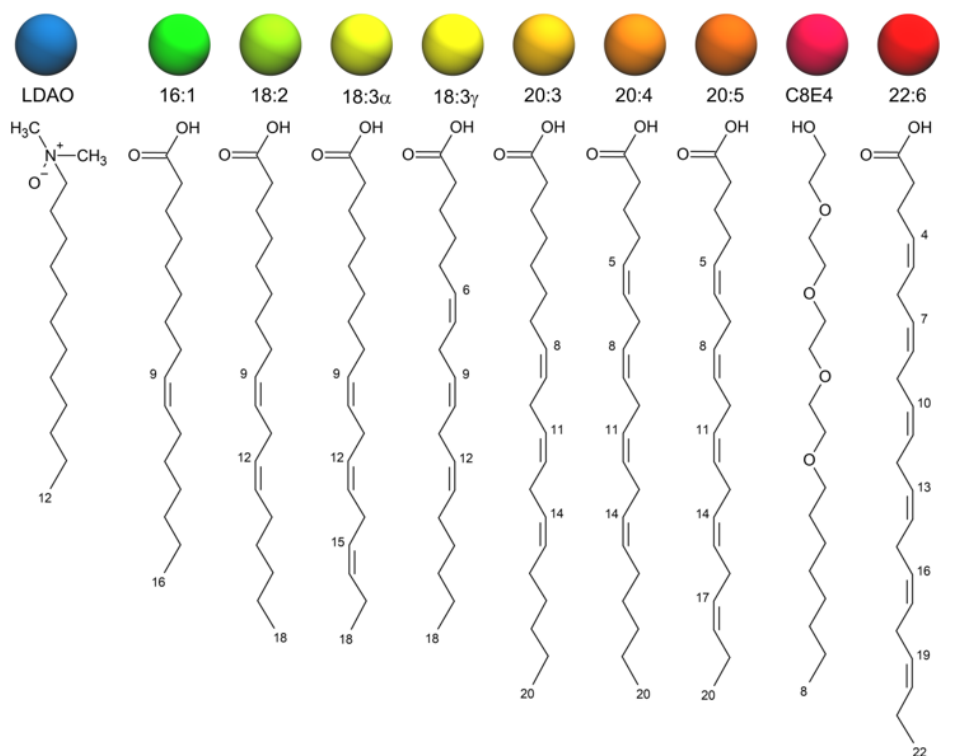
Figure 1. Fatty acids and detergents (LDAO and C8E4) used in docking the FadL homologs. The col- ored spheres show the color scheme associated with the corresponding fatty acid for images used throughout the